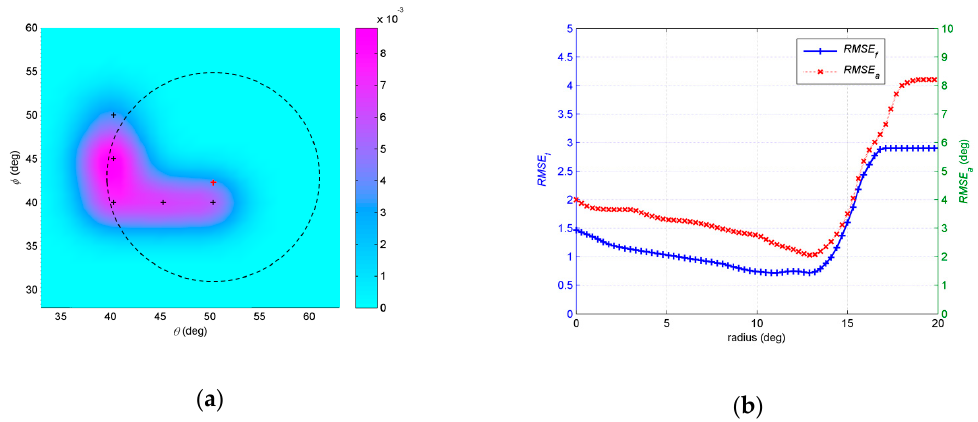
Figure 11. ( a ) Description of assumptive nominal angle (50 ◦ , 42 ◦ ) and circles r equals 13.4 ◦ ; ( b ) RMSE a and RMSE f estimated by different r with assumptive nominal angle (50 ◦ , 42 ◦